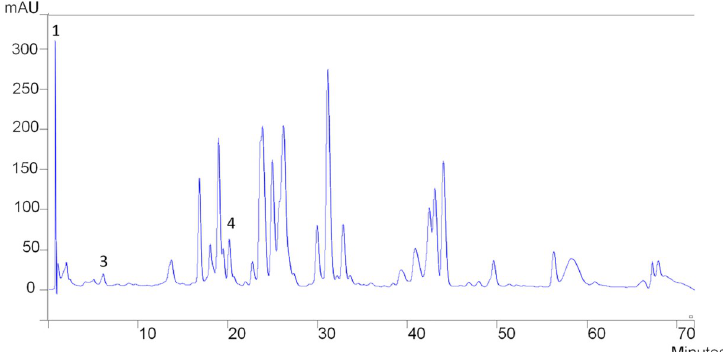
Fig 1. Chromatograms of green propolis ethanolic extract–(1) chatequin, (3) trans-ferulic acid and (4) luteolin.